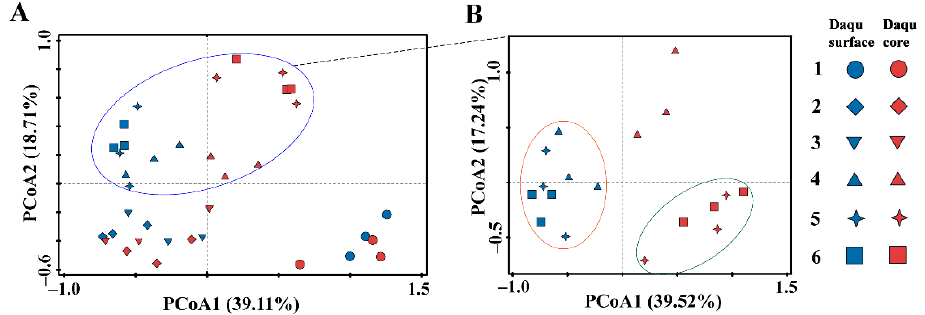
Figure 9. Principal coordinate analysis of fungi during Daqu fermentation. ( A ) Based on 1~6 stages during Daqu fermentation. ( B ) Based on 4~6 stages during Daqu fermentation.